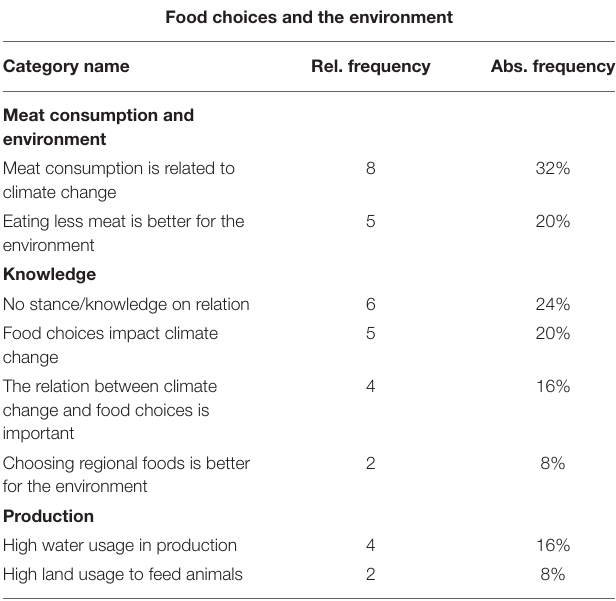
TABLE 4 | Connection between food choices and the environment found in 25 guideline-based interviews (inductive category system; categories with single occurrence are not mentioned in the category system).